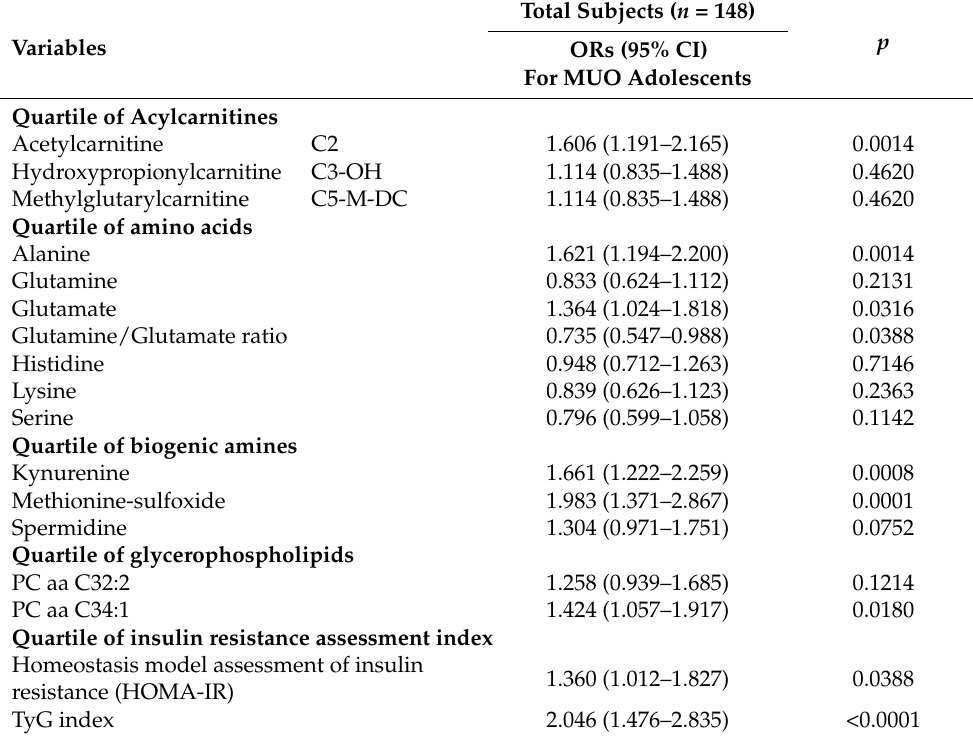
Table 3. Predictors of the MUO adolescents’ prevalence ORs on significantly different